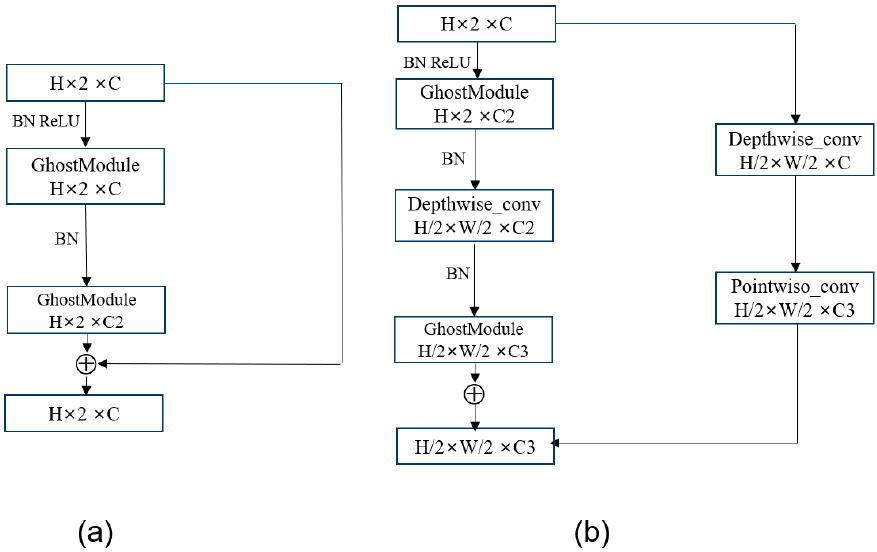
Figure 8. The two G-Bneck structures. ( a ) Stride=1 bottleneck. ( b ) Stride=2 bottleneck. Based on the original CenterNet with ResNet50, we used the G-Bneck to design the backbone of the lightweight landslide detection network CBAM-Mini. The image input size was (512 × 512 × 3). We divided the backbone network into five stages. Apart from the last residual structure, the size of the feature map was unchanged in each stage. In the